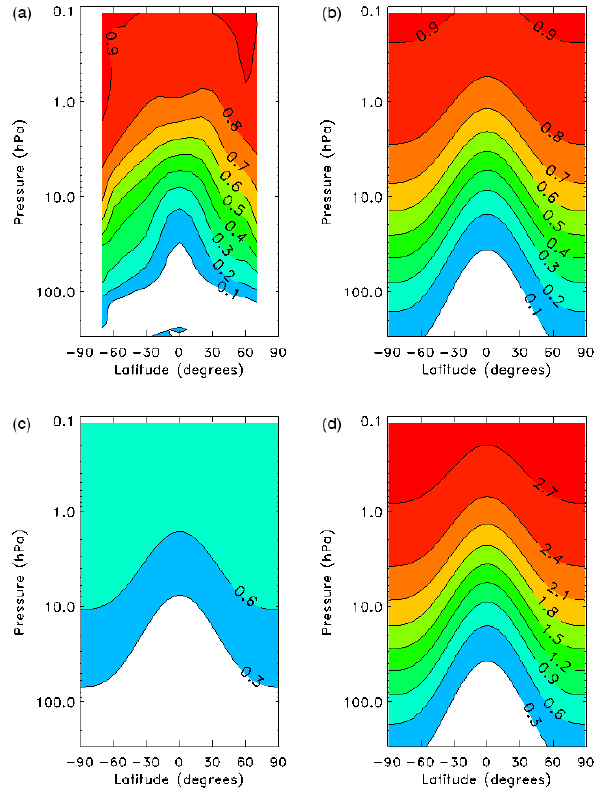
Figure 2. The fraction of oxidised methane (which is linked to CH 4 concentration – see Eq. 1) derived from HALOE data (a) ; the ana- lytical approximation which extends to the poles (b) ; the perturba- tion to stratospheric water vapour (SWV) (ppmv) in pre-industrial conditions, when CH 4 is 0.75ppmv (c) ; the perturbation to SWV (ppmv) if CH 4 is increased to 2.5ppmv (d) .